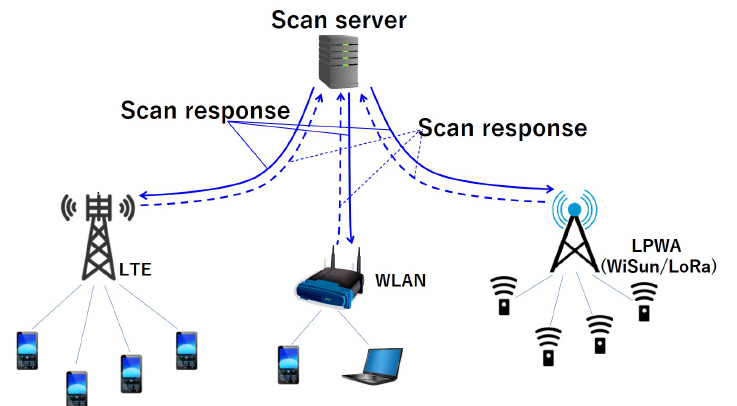
Figure 4. Target network for obtaining scan response that can be used fore cause estimation (only LTE is considered in this evaluation).